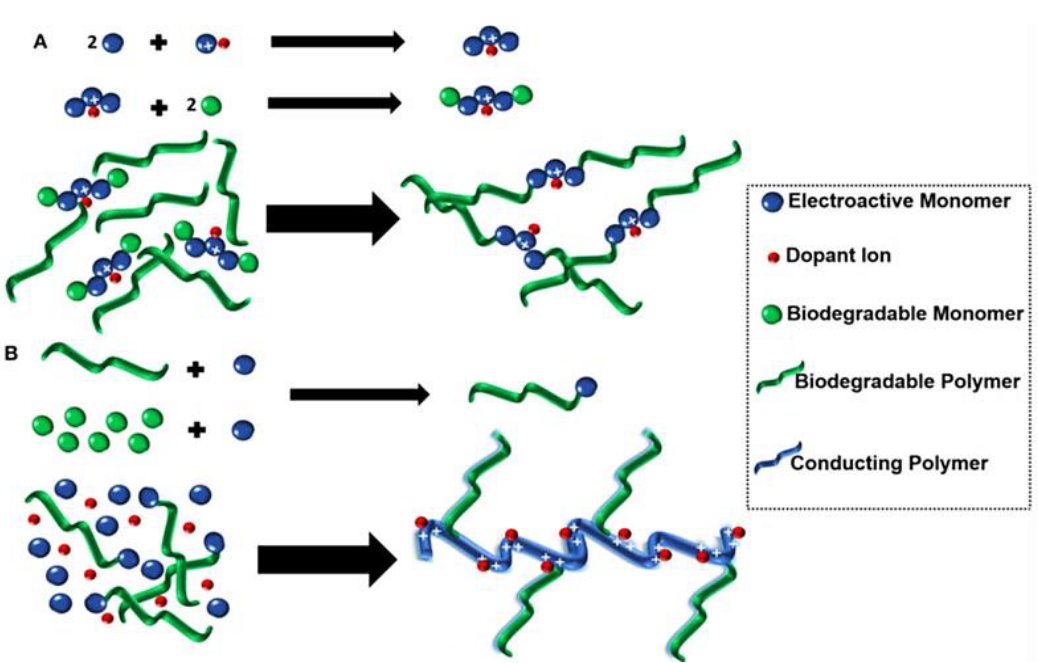
Figure 7. Schematic illustrations for synthesis of ( A ) electroactive oligomers and block copolymers and ( B ) electroactive macromonomers and graft copolymers. Reproduced with permission [68].